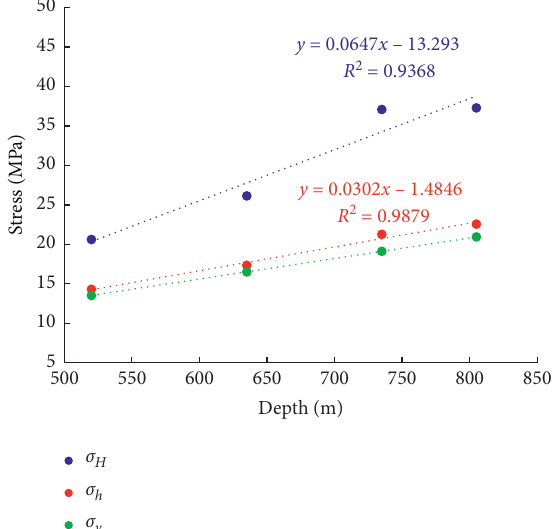
Figure 3: Variation of ZK1 measured in situ stress with depth.